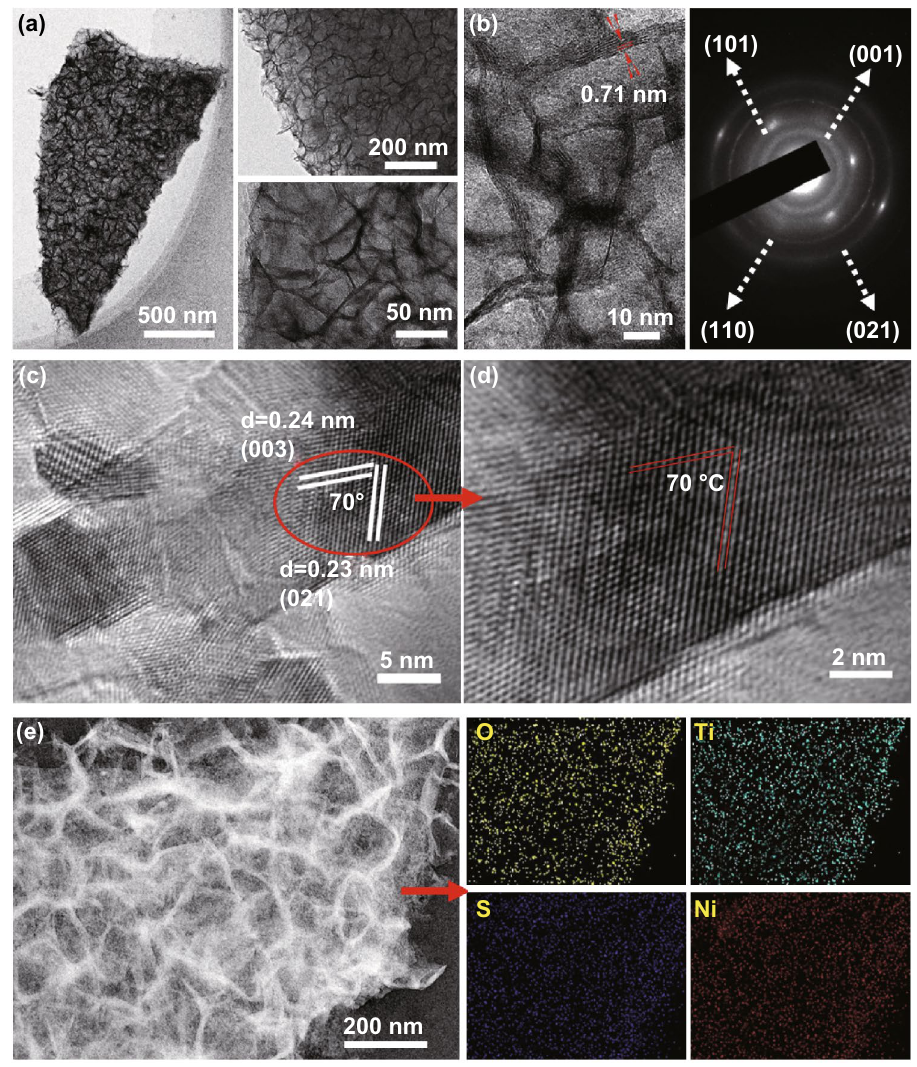
Fig. 2 a – d TEM-HRTEM images and SAED pattern of TiO 2 @Ni 3 S 2 core/branch arrays. e EDS elemental maps of O, S, Ni, and Ti in TiO 2 @ Ni 3 S 2 core/branch